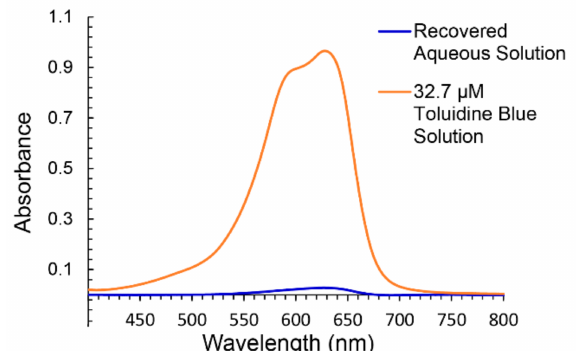
Figure 14. The UV-Vis spectra of the 32.7 µ M TBO solution loaded to the top of the gel in Figure 13b and the liquid collected from the gel column (Figure 13f). The TBO was almost fully absorbed by the